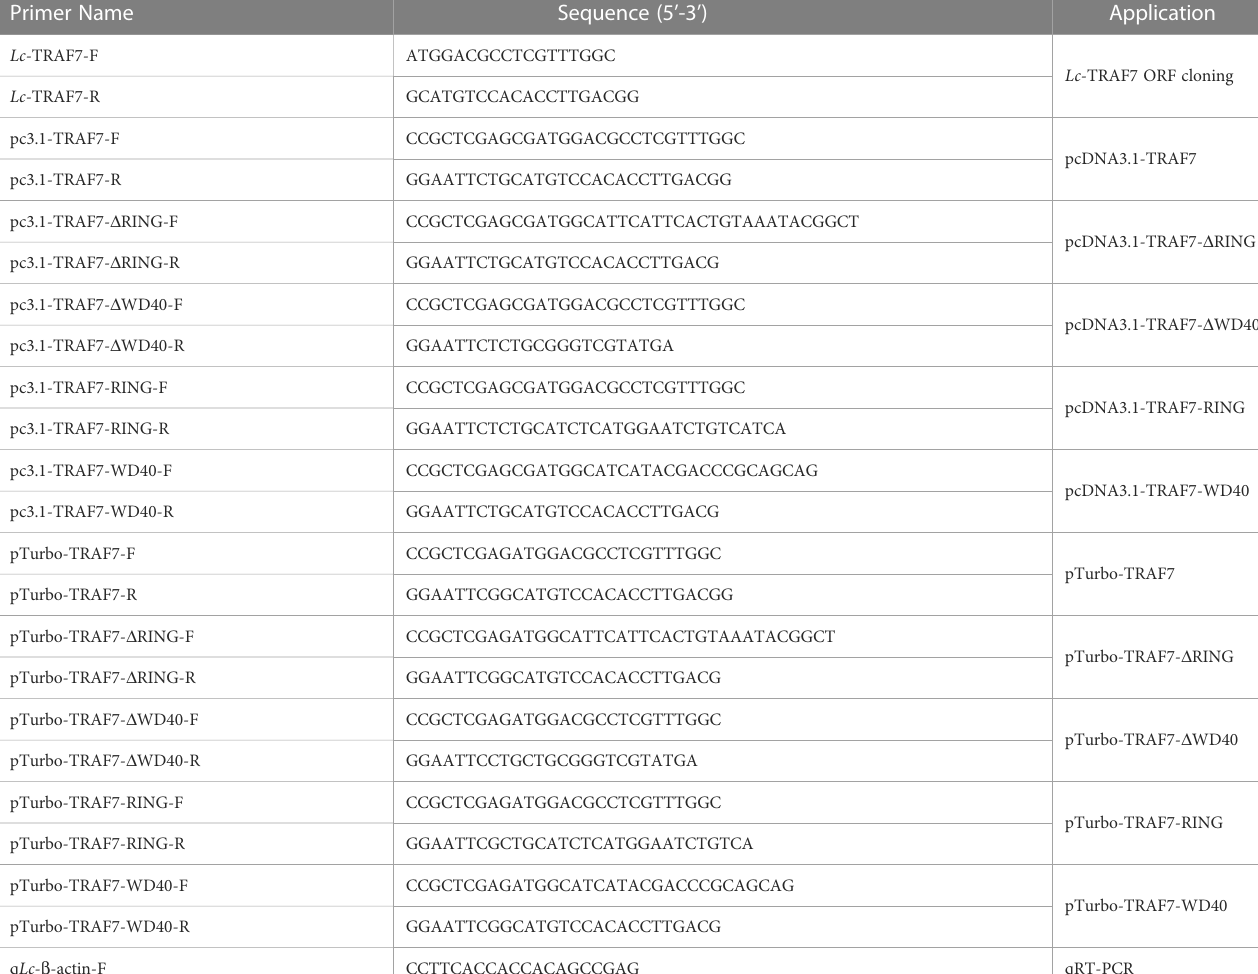
TABLE 1 Primer sequences used in the present